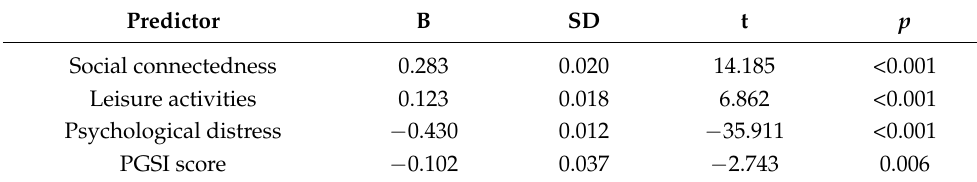
Table 5. Regression analysis for quality-of-life